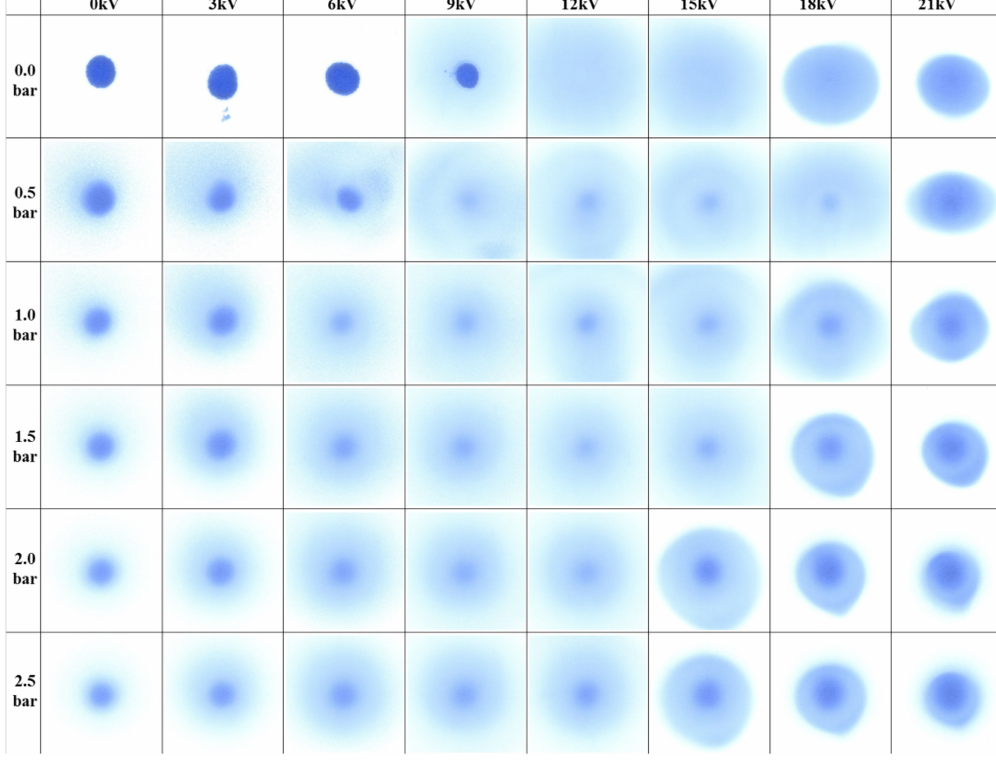
Figure 13. Images of the deposited thin